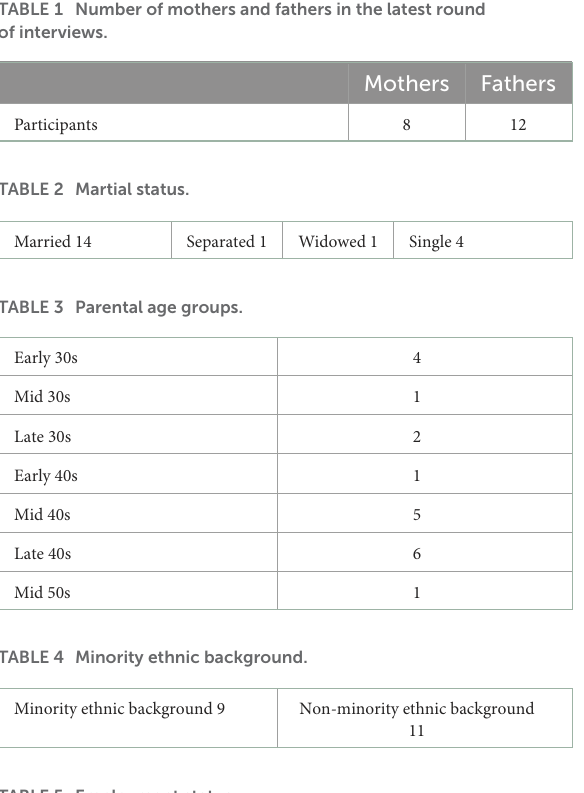
TABLE 5 Employment status.